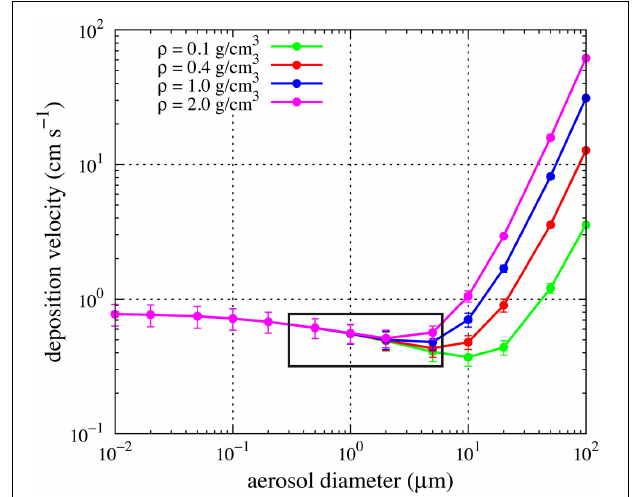
and diameter. Points and error bars indicate mean and standard deviations of the estimate using the observed values of humidity, temperature and wind speed at the different sampling stations in this study. The box indicates the range of diameters relevant for this